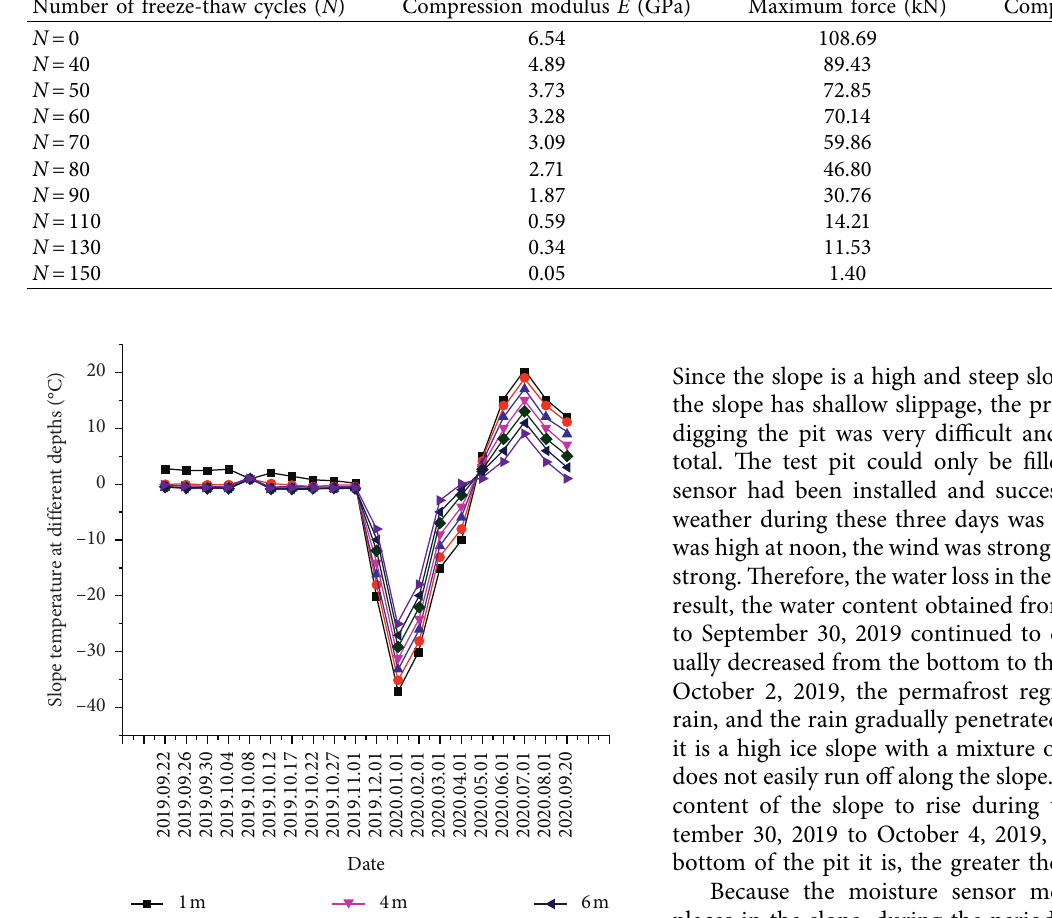
Table 1: Strength values of the representative sample after the different freeze-thaw cycles. Number of freeze-thaw cycles ( N )